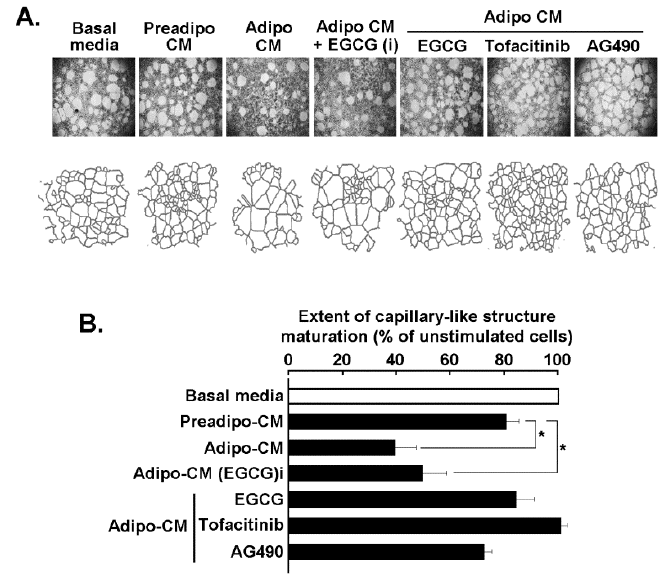
Figure 6. Adipocytes secretome triggers in vitro 3D-capillary-like structure maturation, and STAT3 inhibition prevents such maturation. ( A ) MDA-MB-231 TNBC-derived cells were seeded on Matrigel and cultured for 24 h as described in the Methods section. Representative pictures were taken (upper panels), and digitalized structures used for the analysis presented (lower panels). ( B ) Analysis of the 3D capillary-like structure maturation on Matrigel was performed using ImageJ, and was assessed in the presence of either serum-deprived basal media (unstimulated condition), or stimulation with Preadipo-CM, Adipo-CM, or Adipo-CM (i) (CM harvested upon ADMSC differentiation in the presence of 30 µ M EGCG). Acute additions of EGCG, Tofacitinib, or AG490 (all at 30 µ M) were done in the presence of Adipo-CM to the cell culture. Significance: * p < 0.05.